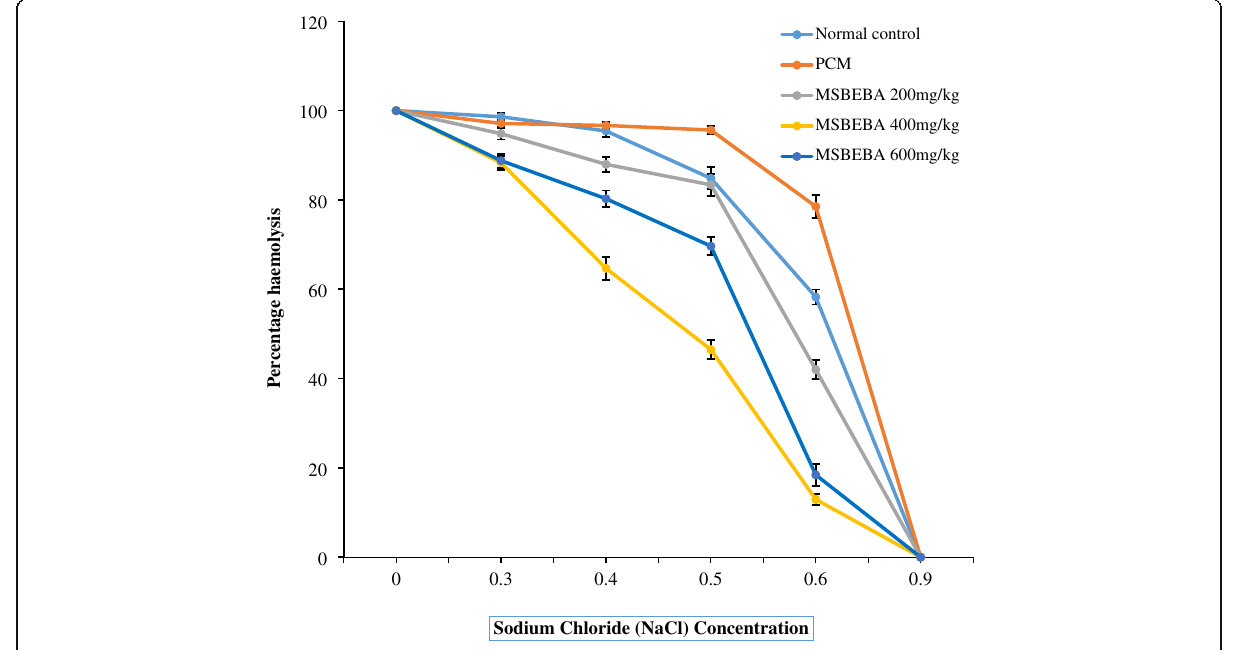
Fig. 1 Percentage erythrocyte osmotic fragility of acetaminophen-treated